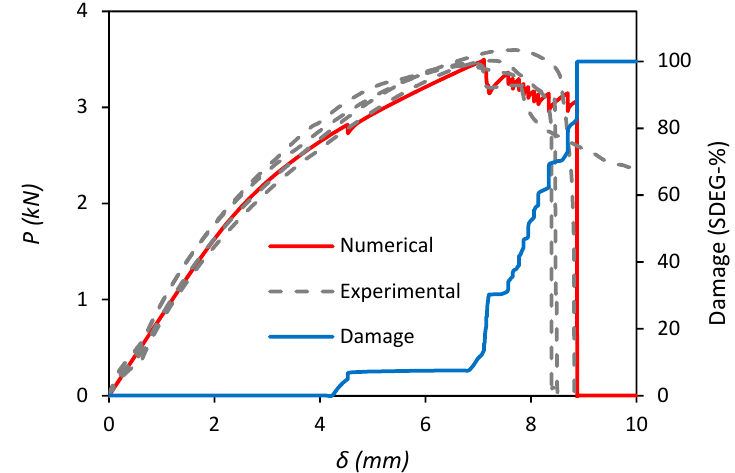
Figure 12. Load-displacement ( P– δ ) responses of the lap-shear joint for numerical simulation, damage evolution (SDEG-%) and experimental tests.